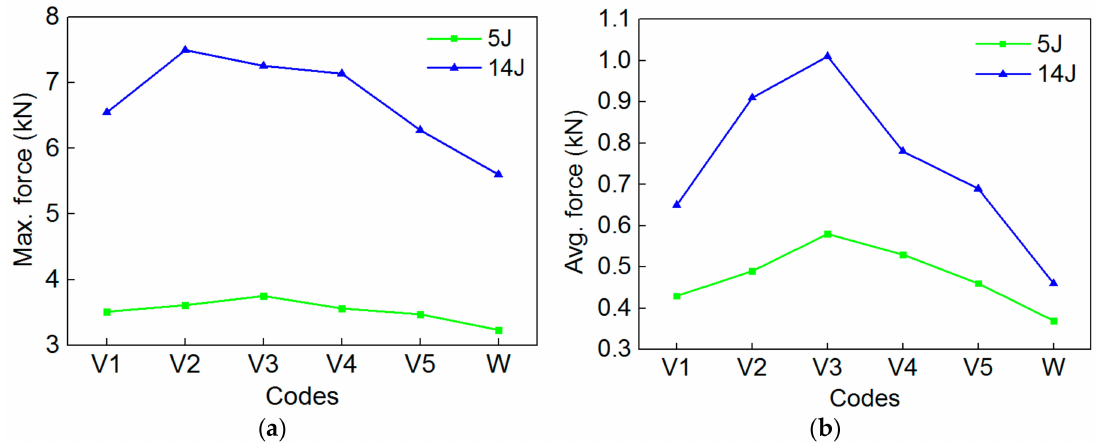
Figure 12. The maximum contact force and average contact force value of specimens of V1/V2/V3/V4/V5/W under the two impact energies: ( a ) Max. force; ( b ) Avg. force.